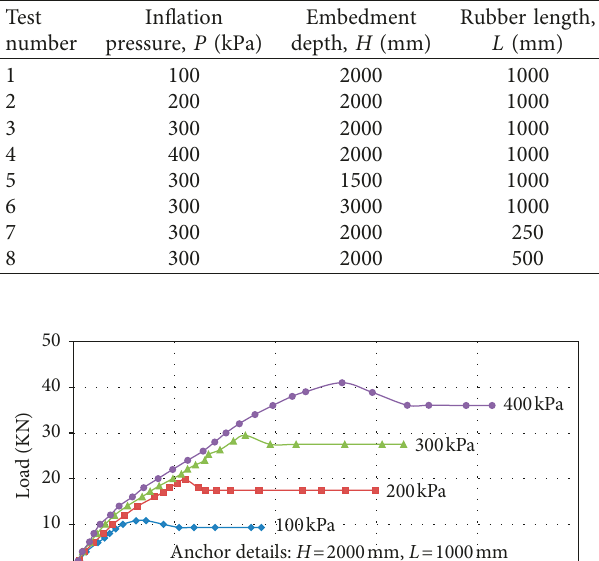
Table 1: Summary of the conducted tests.